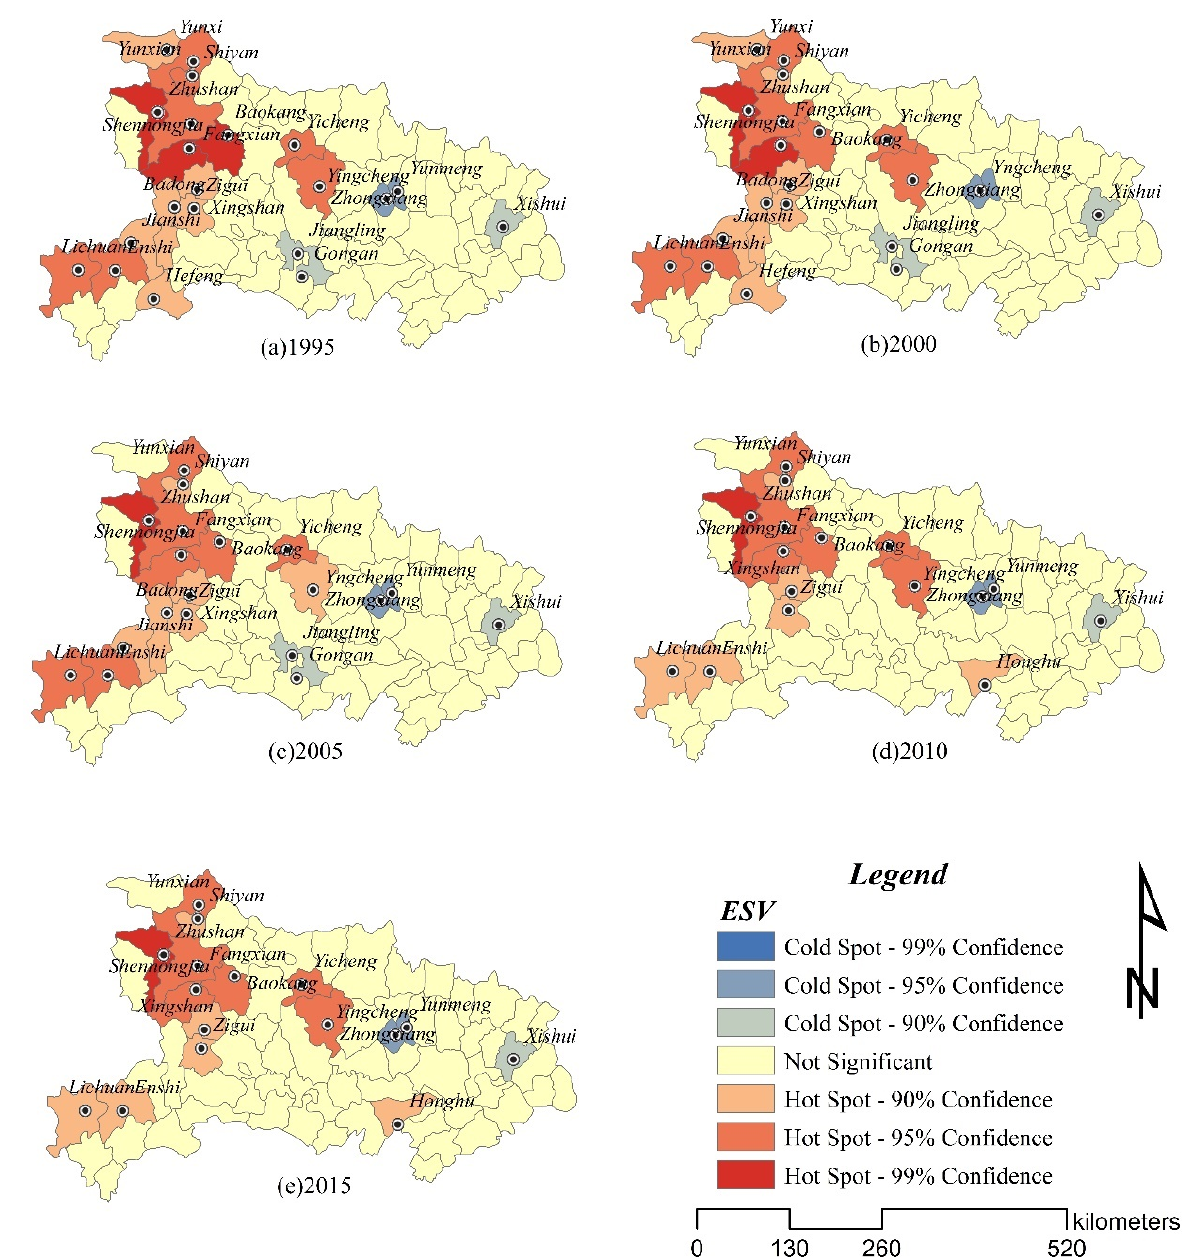
Figure 4. Hot spot analysis in Hubei province from 1995 to 2015. The calculation of geographical gravity center can help to more accurately grasp the temporal and spatial pattern of ESV from a dynamic perspective. As shown in Figure 5, From 1995 to 2010, the gravity center of ESV shifted from northwest to southeast, with an offset angle of 23.5 ◦ and an offset distance of 5.099 km. From 2010 to 2015, the rapid development of urbanization in Hubei province led to a sharp decrease in cropland and forest land, which reduced the value of ecosystem services. The center of ecosystem services value shifted in the opposite direction, with an offset angle of 2.5 ◦ , but the deviation distance was not large. During the study period, the focus of ESV was within the boundary of Jingmen City. The results showed that the provision of ecosystem services in Hubei province showed a positive trend from 1995 to 2010, and the ecology in the eastern region was recovering. The ecosystem situation in Hubei province rebounded from 2010 to 2015, which was consistent with the change of ecosystem service values in Hubei